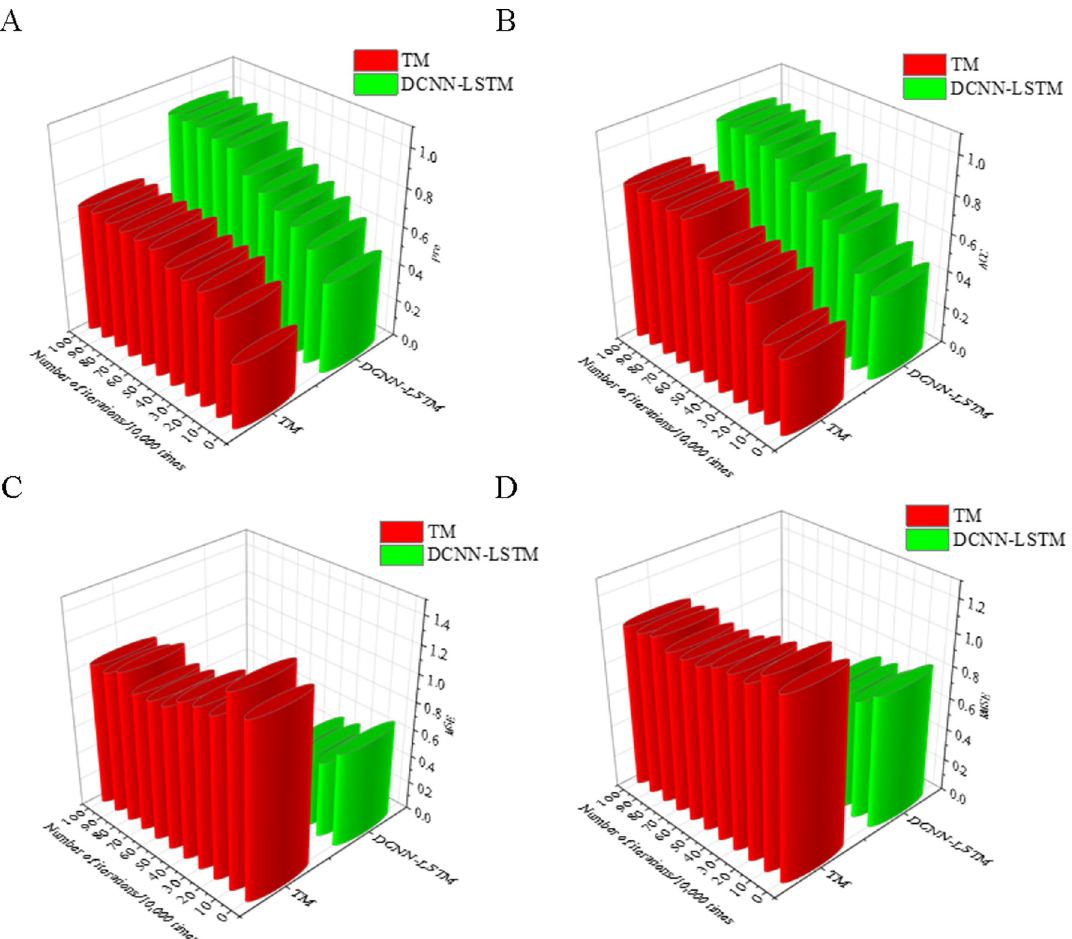
Fig 11. Overall performance evaluation results of the model. Note: TM represents the traditional detection method of table tennis tactical indicators, and DCNN-LSTM represents the fusion algorithm model in